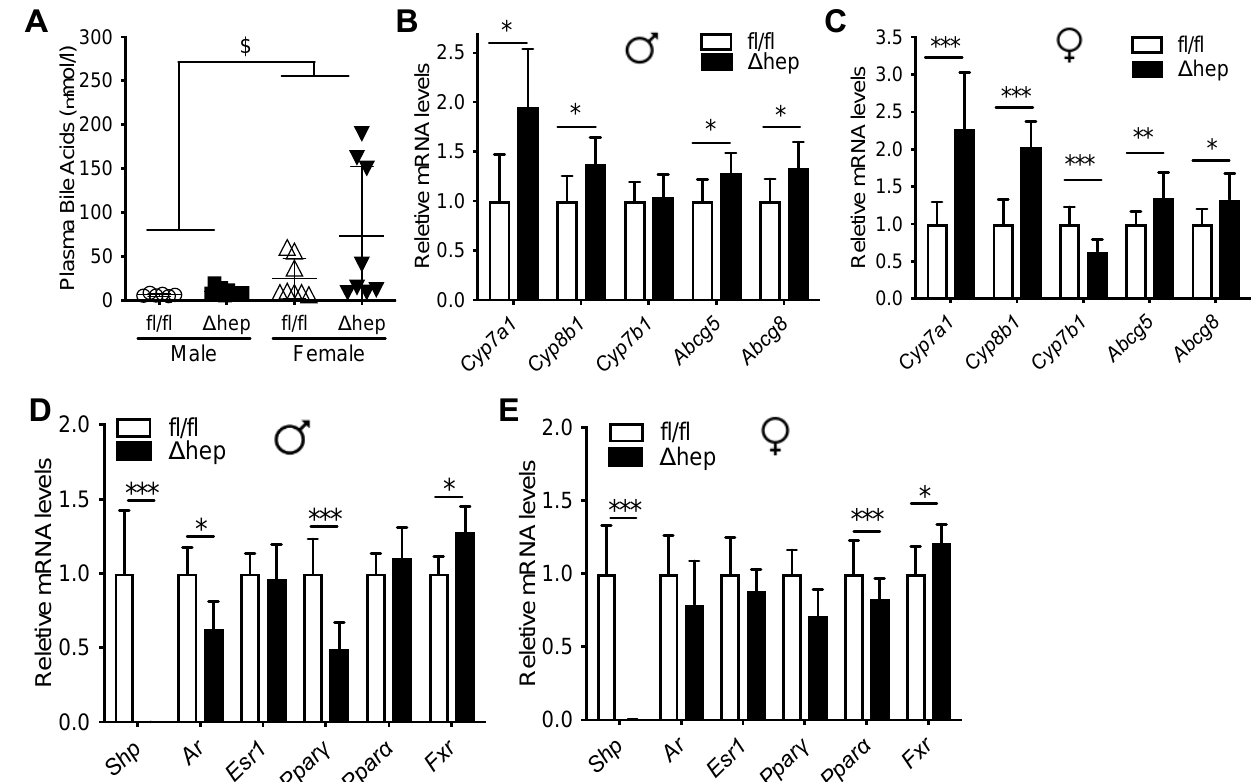
Figure 2. Effect of hepatic deletion of SHP on bile acids. Ad lib chow fed male and female SHP fl/fl and SHP ∆ hep littermates were used for the study. ( A ) Plasma bile acids. $ p < 0.05 for sex effect (2-way ANOVA). ( B , C ) Hepatic deletion of SHP increased liver expression bile acid metabolism genes similarly in males ( B ) and females ( C ). ( D , E ) Hepatic deletion of SHP reduced expression of Androgen receptor ( Ar ) and Ppar γ in males ( D ), but not females ( E ). * p < 0.05, ** p < 0.01, *** p < 0.001 ( t -test). 2.3. Effect of Gonadectomy on Hepatic SHP Regulation of Plasma TGs in Males and Females